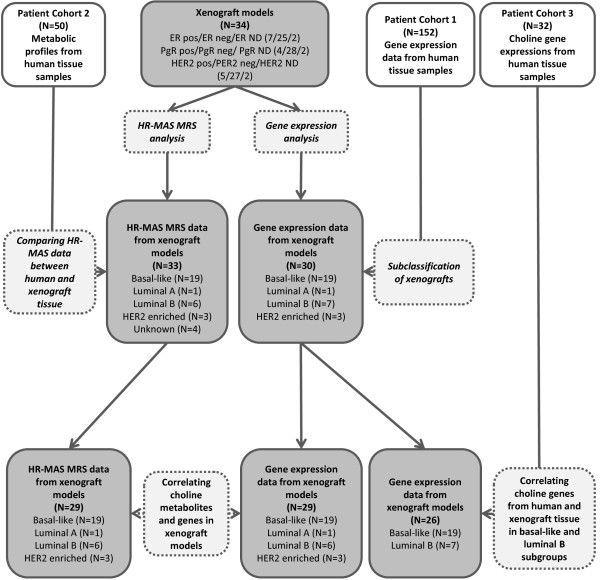
Flowchart of xenograft samples, human tissue samples and experiments. The study includes 34 xenograft models (grey rectangles) and tissue samples from three patient cohorts (white rectangles). The experiments performed on the xenografts and human tissue samples are shown by dashed rectangles. ER, estrogen receptor; HER2; human epidermal growth factor receptor 2; ND, not determined; PgR, progesterone receptor.